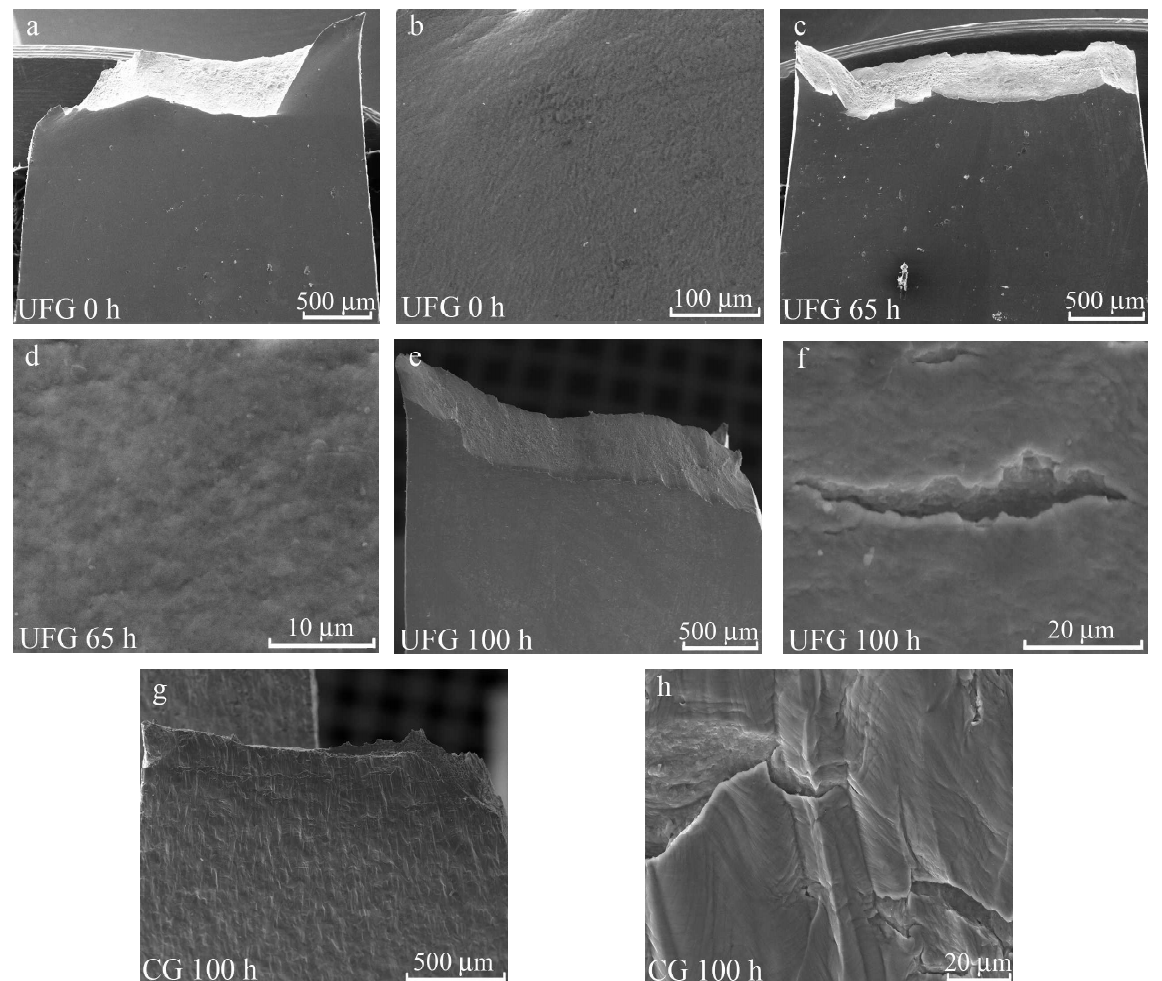
Fig. 11. SEM micrographs of the side-surfaces of the UFG-CrNiMo (a-f) and CG-CrNiMo (g, h) steel speci- mens depending on hydrogen-charging regime: a, b – hydrogen-free, c, d – hydrogen-charged for 65 hours, e-h – hydrogen-charged for 100 hours. Images (b, d, f, h) are magnified elements of the images (a, c, e, g) obtained near the fracture